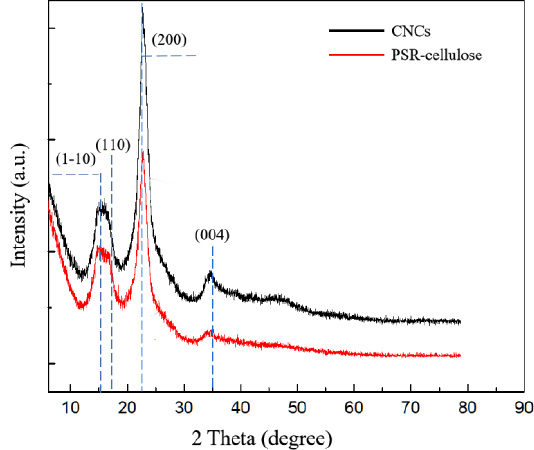
Figure 4. XRD spectra of PSR-cellulose and CNCs.